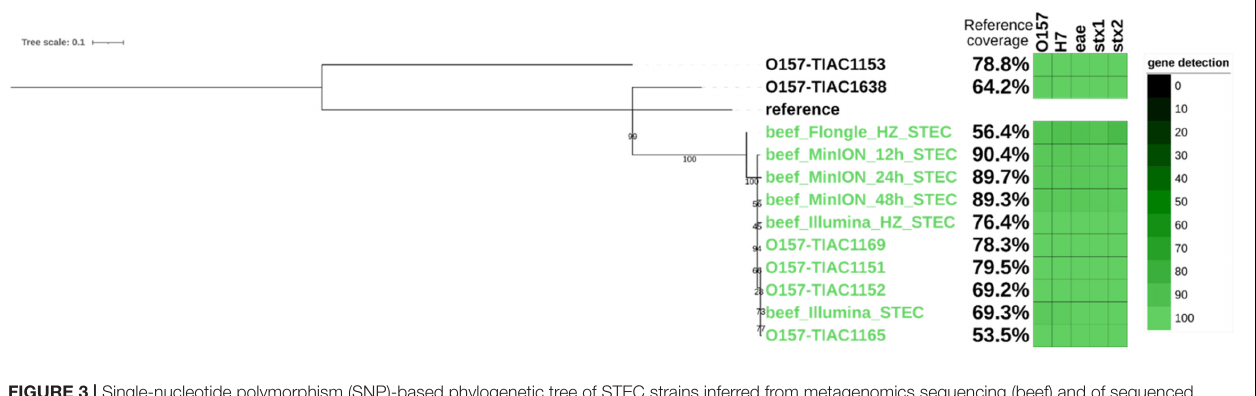
FIGURE 3 | Single-nucleotide polymorphism (SNP)-based phylogenetic tree of STEC strains inferred from metagenomics sequencing (beef) and of sequenced isolates with percentage of the reference genome covered (i.e., percentage of reference genome that is useful for SNP analysis, see section “Materials and Methods”) and gene detection (O-type and H-type and genes eae, stx1, and stx2; green shaded blocks representing the query coverage) in each strain represented on the side of the branch. Isolates TIAC 1151, 1152, 1153, and 1638 are from food origin. Isolates TIAC 1165 and 1169 are from human origin. Reference: E. coli O157:H7 str. Sakai (BA000007.3). Green: closely related strains from the outbreak cluster. Black: sporadic cases outside the outbreak cluster. The scale bar represents nucleotide substitution per 100 nucleotide sites. Node values represent bootstrap support